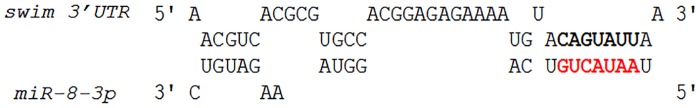
Predicted interactions between miR-8-3p and its putative target secreted wingless-interacting molecule (swim).The interaction between the seed sequence of miR-8-3p (in red) and the complementary sequence in the 3’ UTR of swim, indicated with bold text, is energetically favorable (MFE = -21.56).